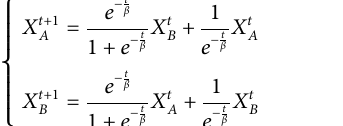
Figure 3 indicates the differing principles of adaptive crossover and a-function arithmetic crossover, where we use different colors, i.e., orange, green, pink and blue, to distinguish